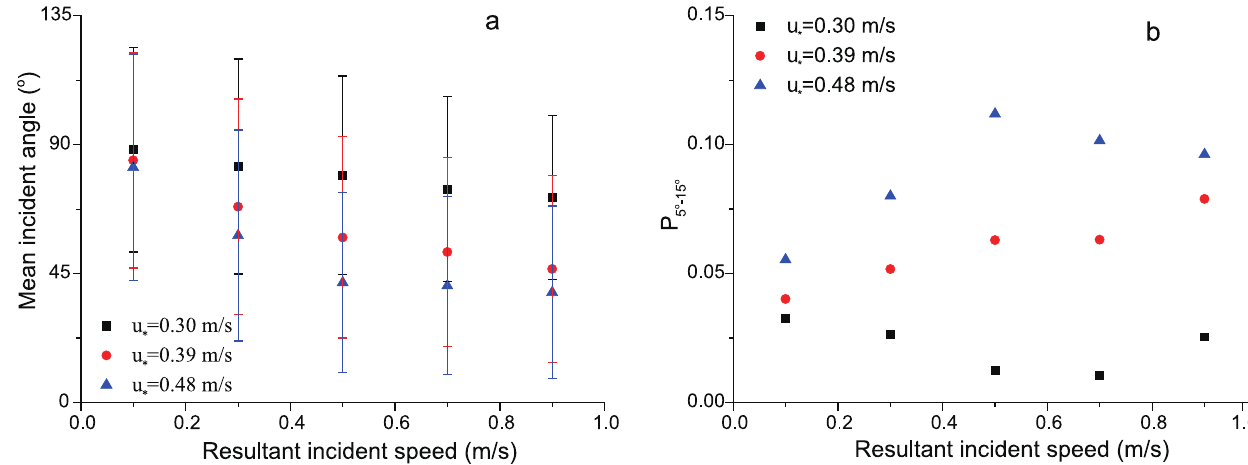
Figure 7. The mean incident angle (a) and the proportion of 5 6 –15 6 incident angles ( P 5 { 15 0 ) (b) versus resultant incident speeds of particles.